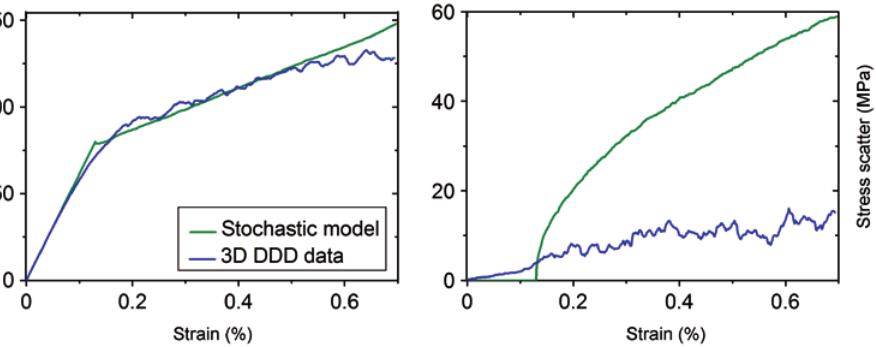
Figure 7: Left, average stress of DDD simulations (blue line) and stochastic simulations (green line). Right, stress standard deviation of DDD simulations (blue line) and stochastic simulations (green line).